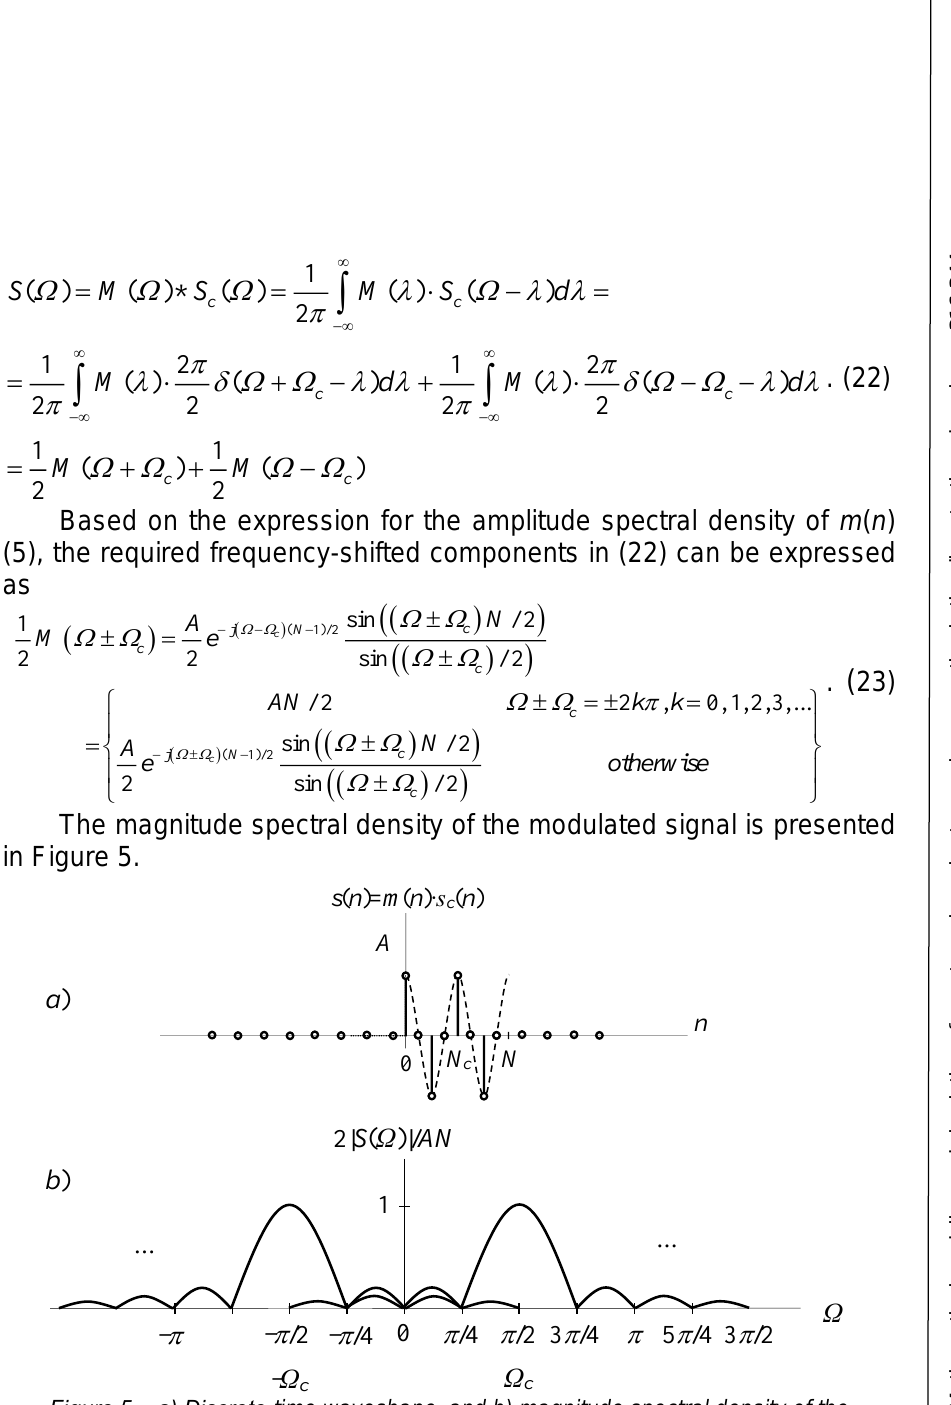
Figure 5 − a) Discrete-time waveshape, and b) magnitude spectral density of